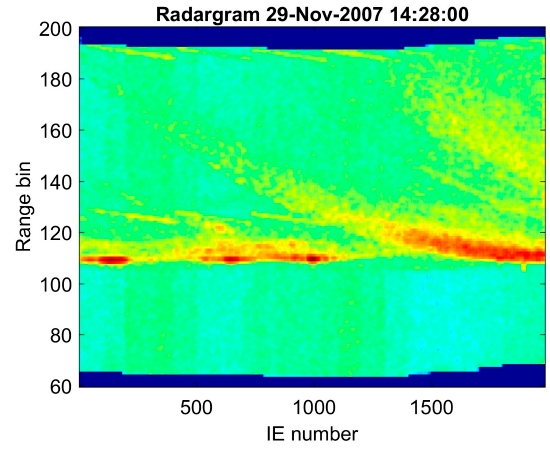
Figure 10. Radargram for the Rio Nahuapa case.